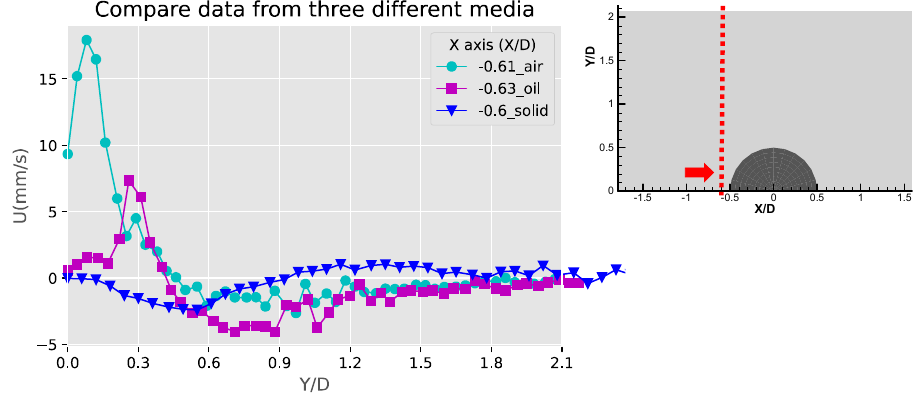
Figure 13. Comparison of the X-component velocity (U) profiles at the left side of the obstructions (X/D = −0.6).